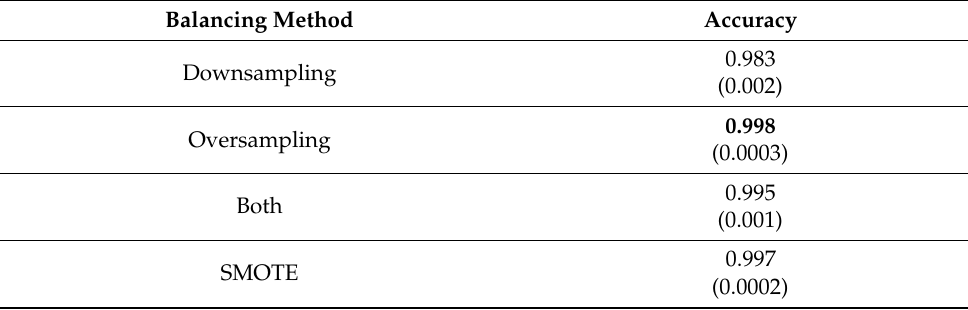
Table 7. Accuracy values after data balancing for randomly stratified